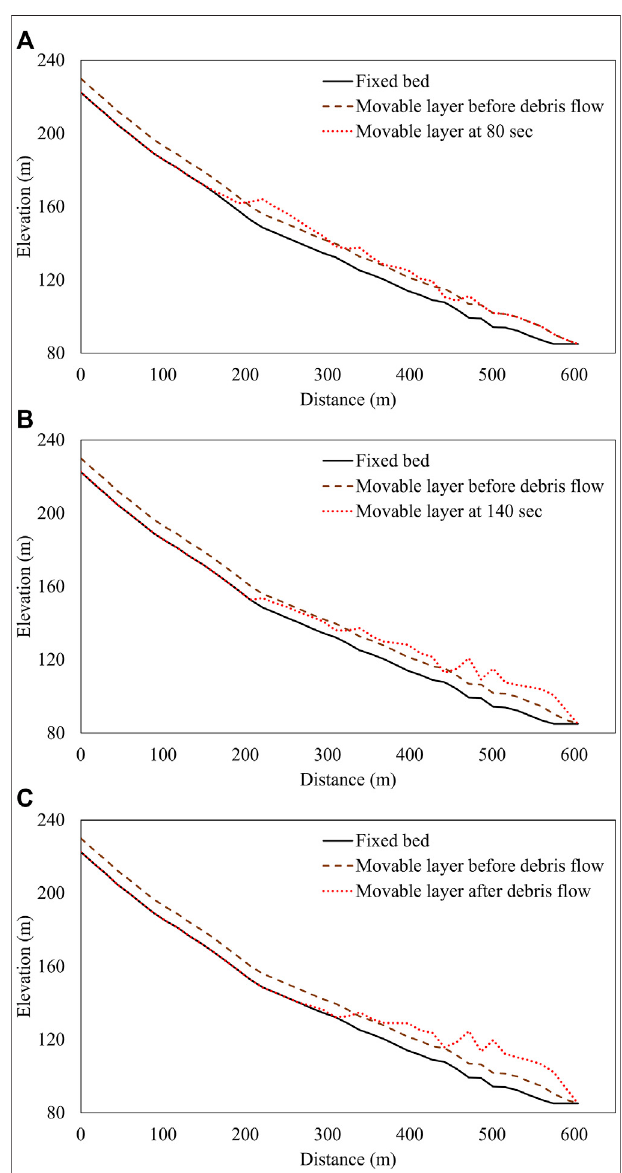
FIGURE 7 | Change in the erodible layer after debris fl ow simulation withoutadamafter (A) 80 s, (B) 140 s,and (C) post-simulation.Theblackline is the fi xed channel bed; the brown dashed and red dotted lines represent the movable layer before and after debris fl ow, respectively. Note that movablelayers(browndashedandreddottedlines)arenotdrawnatarealistic scale; they are exaggerated by fi ve times their actual values for visibility.